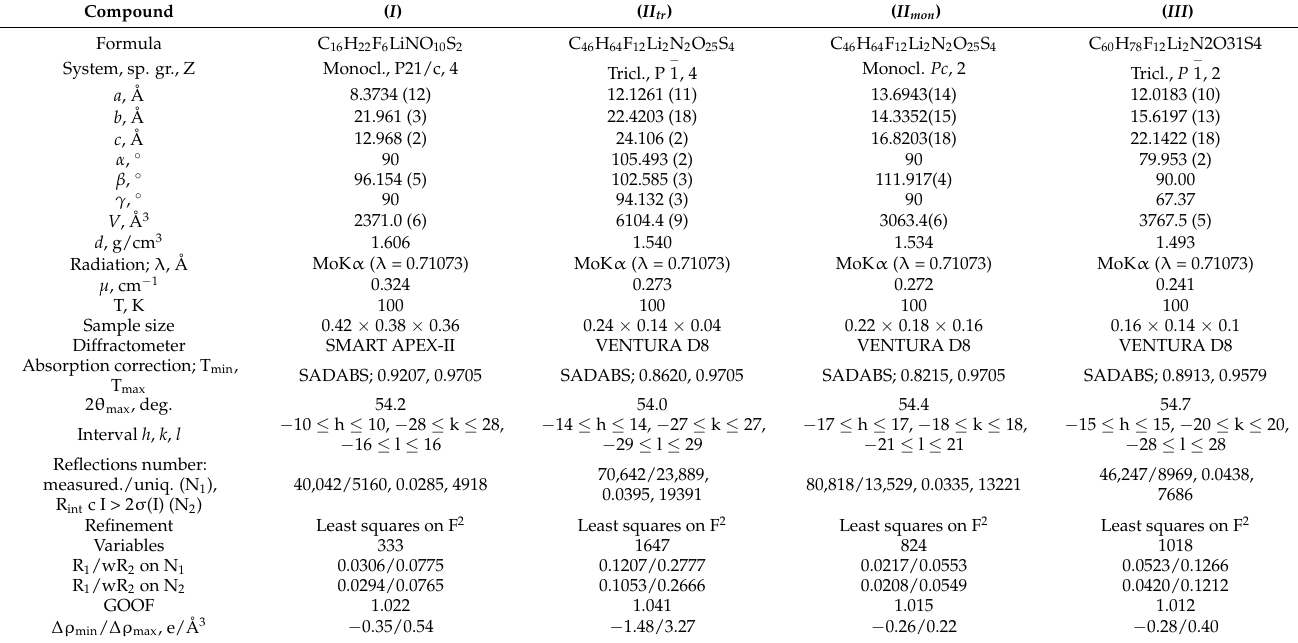
Table 3. Crystallographic parameters, characterization of X-ray data collection, and structure refine- ment for ( I ), ( II tr ), ( II mon ), and ( III